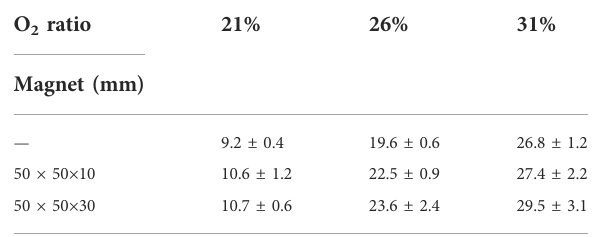
TABLE 2 Soot mass collected by quartz plate (Unit: